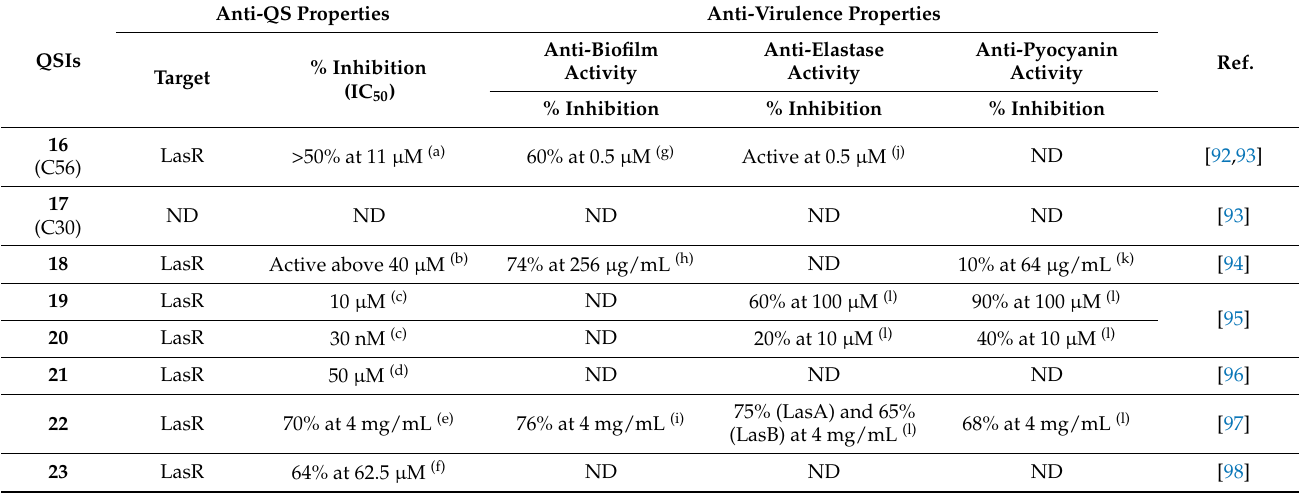
Table 2. Anti-QS and anti-virulence properties of AHL autoinducer non-analog QSIs.